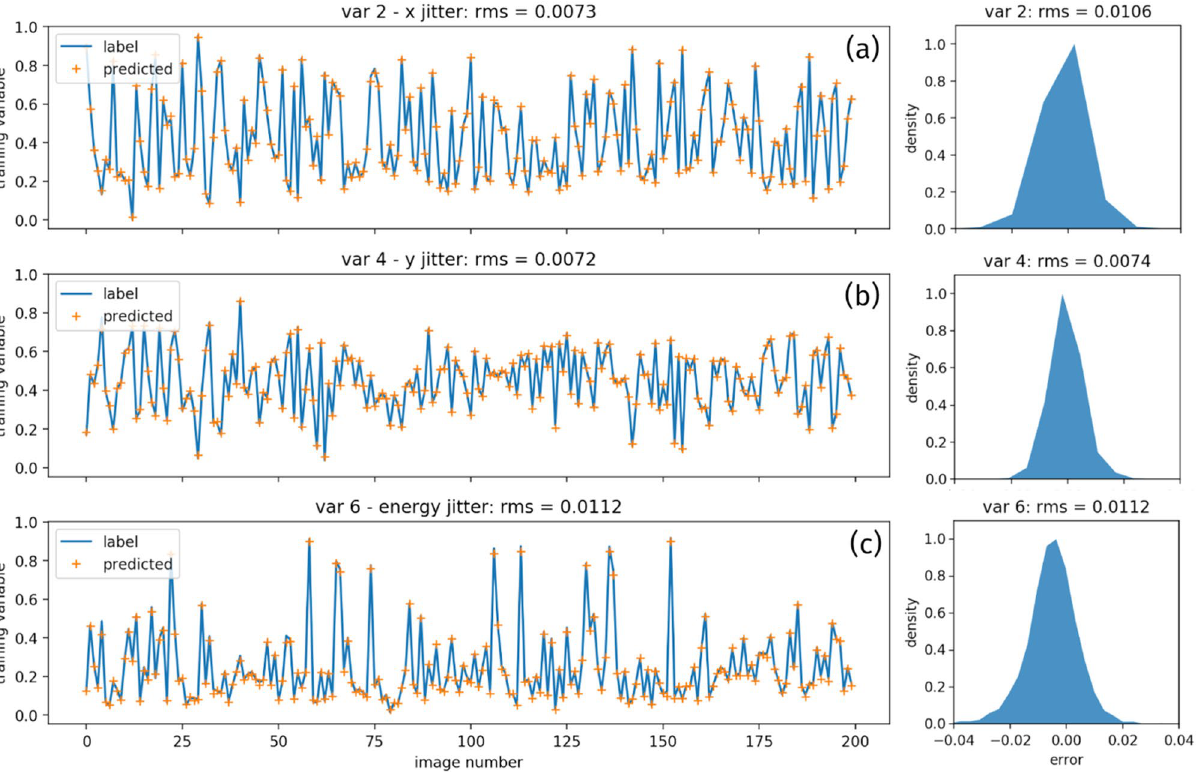
Figure 8. Training variables 2 ( a ), 4 ( b ), and 6 ( c ), labels are plotted as the blue curve while their corresponding predictions as the result of the polar ML model are plotted as the orange crosses respectively for the untrained two hundred images. Besides, their corresponding error distributions for the entire dataset of five thousand images are plotted on the right side. The RMS errors for the untrained images and the entire dataset agree extremely